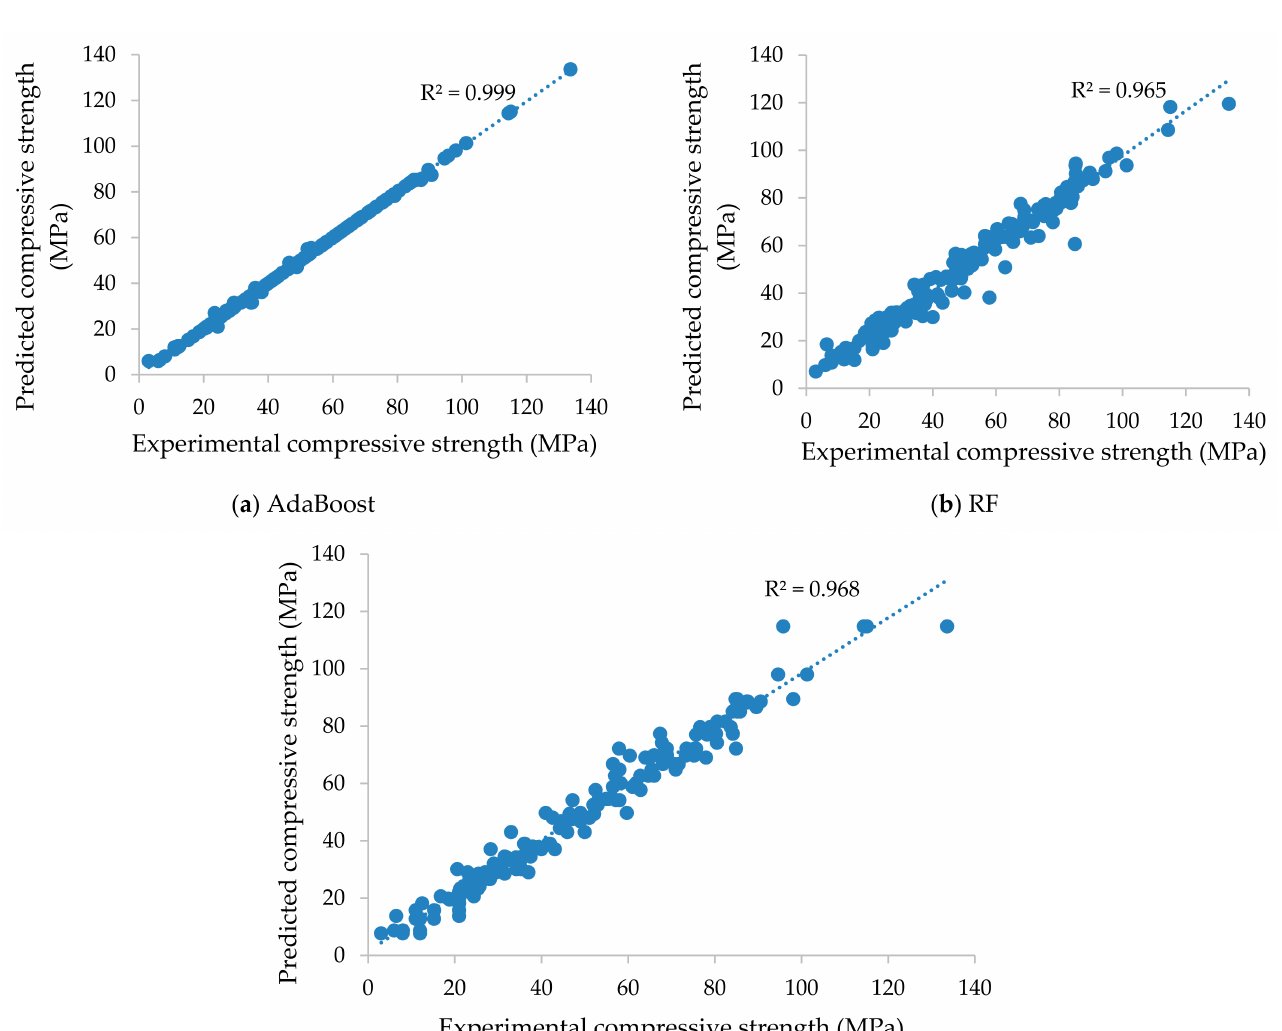
Figure 3. Scatter plots displaying the experimental (actual) compressive values versus the predicted compressive values of concrete at high temperature of the training dataset using the ( a ) AdaBoost, ( b ) RF, and ( c ) DT